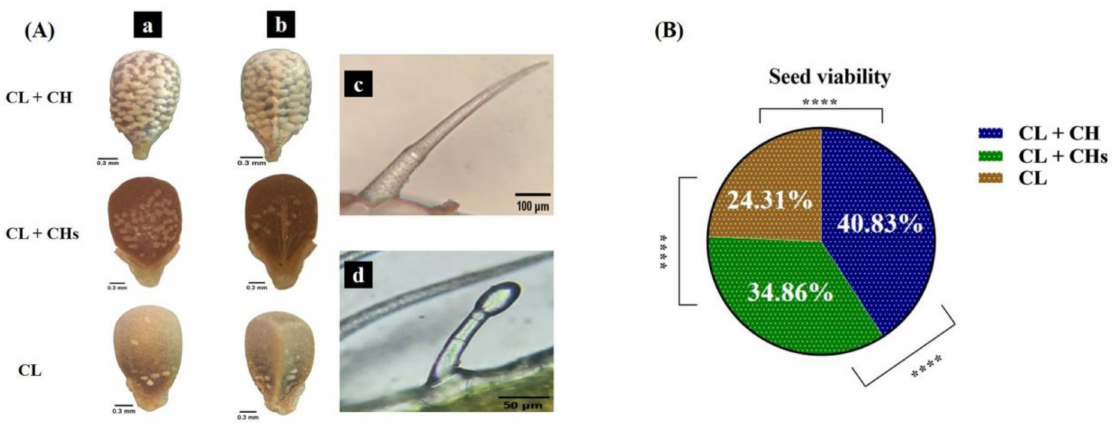
Figure 7. Nutlets, trichomes, and seed viability in the three morphs ( A ) Nutlets (a: dorsal view & b: ventral view) and trichomes (c: non-glandular & d: glandular) ( B ) Seed viability. ****: p - value ≤